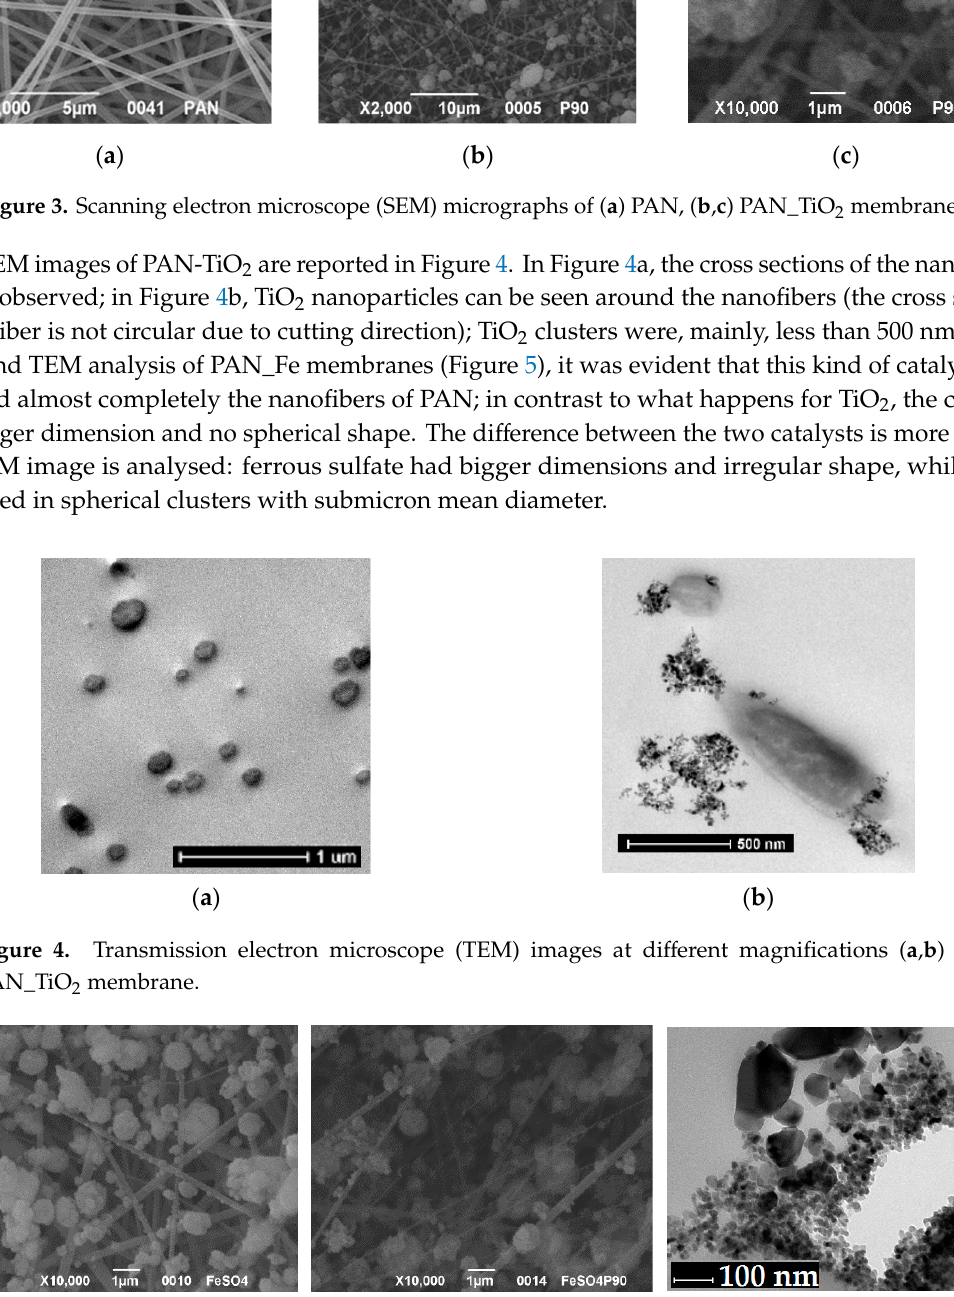
Table 2. Catalyst content of the membranes.